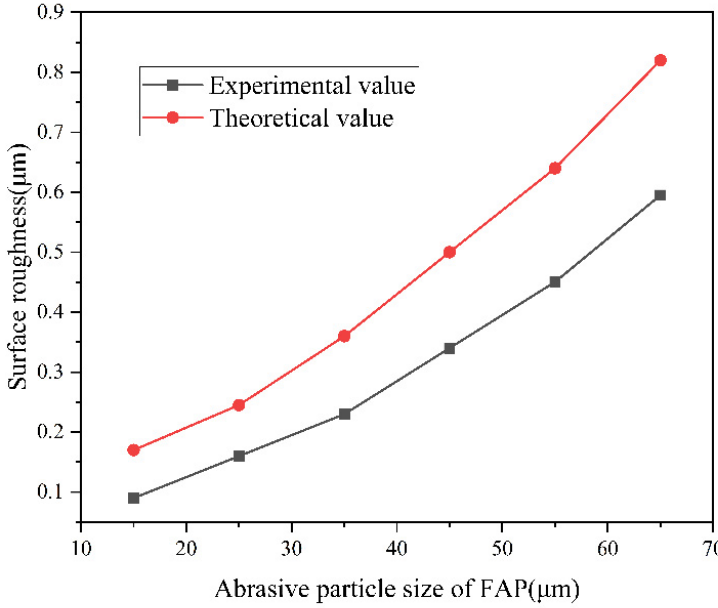
Figure 8. Comparison of experimental and theoretical results of surface roughness.